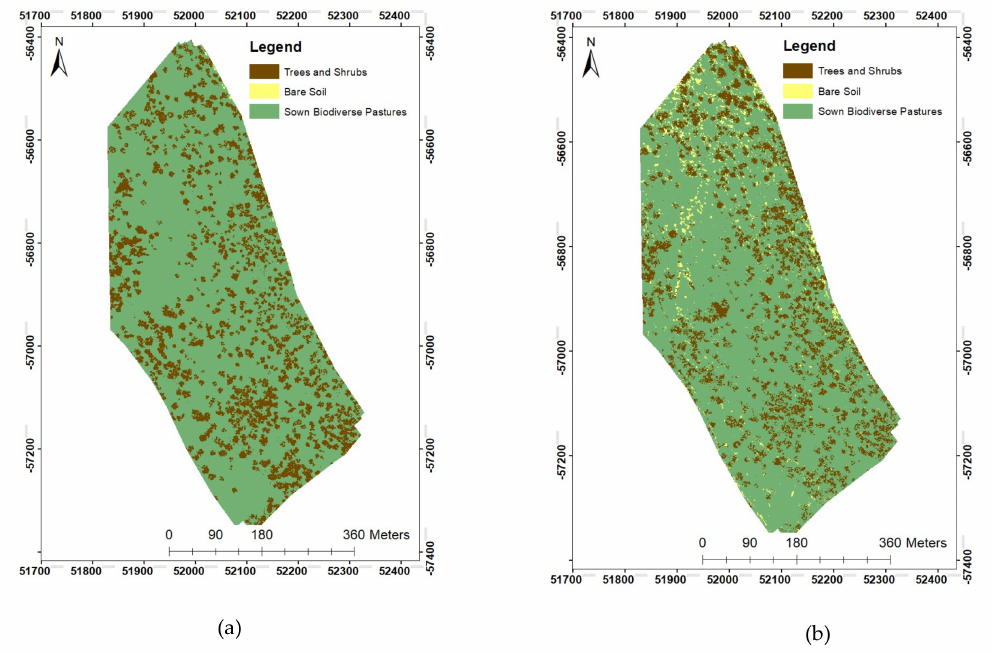
Figure A3. Land cover maps produced through multitemporal classification using Support Vector Machines ( a ) and Artificial Neural Networks ( b ) for farm 1.